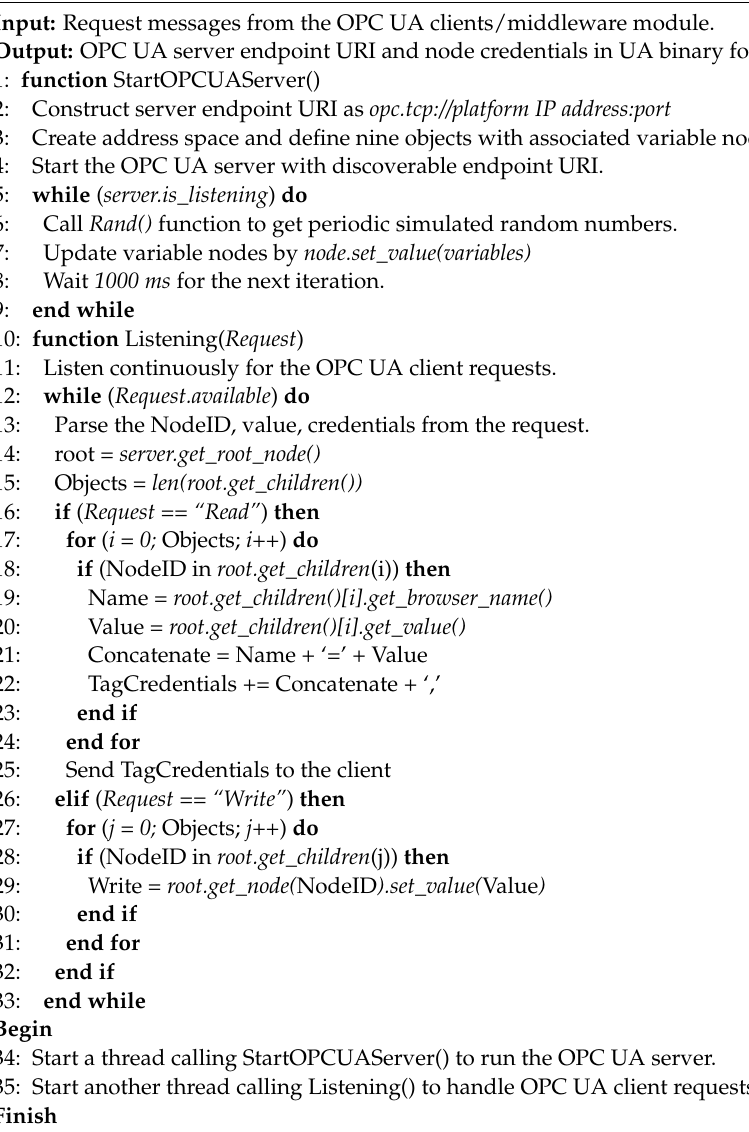
Algorithm 1. OPC UA Server Development